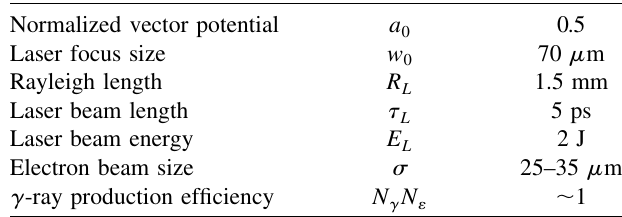
TABLE I. CO laser- and e -beam parameters at the Compton 2 IP.